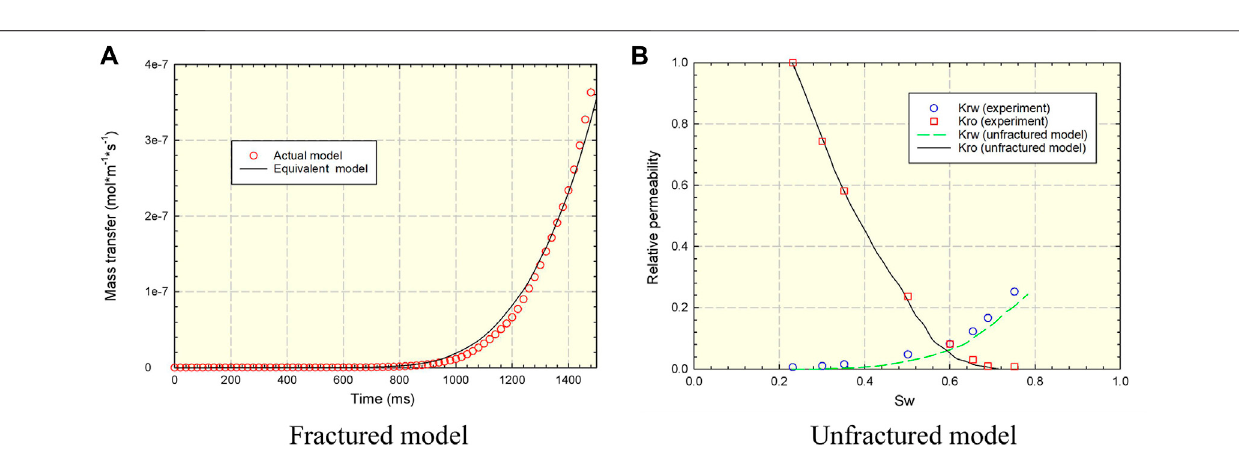
Frontiers in Earth Science |